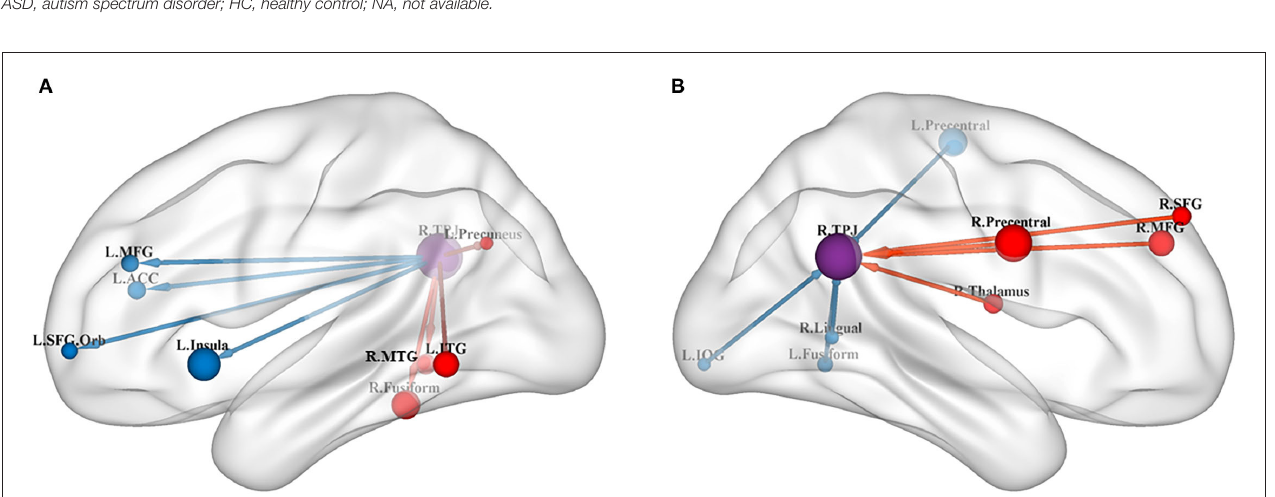
FIGURE 1 | (A) Results of GCA from the RTPJ to the whole brain. (B) Results of GCA from the whole brain to the RTPJ. The red and blue lines represent increased or decreased effective connectivity between brain regions, respectively. The arrows demonstrated the direction of information transferred between brain regions. RTPJ, right temporoparietal junction; L.Fusiform, left fusiform; R.Fusiform, right fusiform; L.ITG, left inferior temporal gyrus; R.MTG, right middle temporal gyrus; L.Precuneus, left precuneus; L.Precentral, left precentral gyrus; R.Precentral, right precentral gyrus; L.Insula, left insula; L.ACC, left anterior cingulate cortex; L.MFG, left middle frontal gyrus; R.MFG, right middle frontal gyrus; L.SFG.Orb_L, left superior frontal gyrus, orbital part; R.SFG, right superior frontal gyrus; R.Thalamus, right thalamus; R.Lingual, right lingual; L.IOG, left inferior occipital